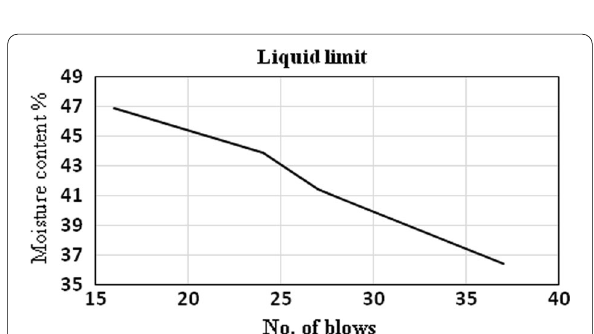
Fig. 5 Water content and liquid of the clay sample . Liquid limit (water content at 25 blows)